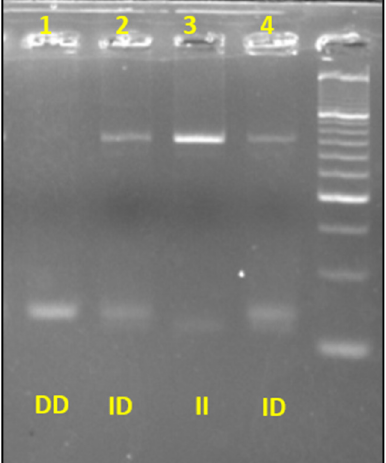
Figure 2. Electrophoretic profiles of three genotypes obtained by PCR of ACE I/D. For rs1815739 ACTN3 variant, PCR amplification products were loaded on an elec- trophoresis 2% agarose gel to verify the PCR efficiency. Following, an enzyme digestion was performed, adding 15 µ L of PCR product, 0.5 µ L of DdeI Restriction Enzyme associated with 2 µ L of Buffer D (Promega, Madison, WI, USA) and 0.5 µ L of BSA. Total volume was